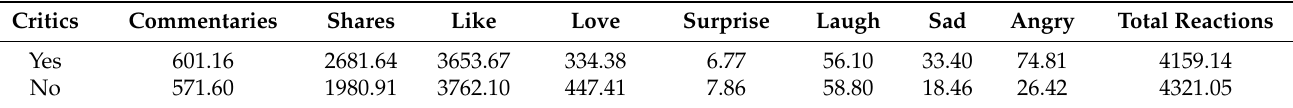
Table 5. Average Interaction According to Whether the Messages of the Political Actors Contain